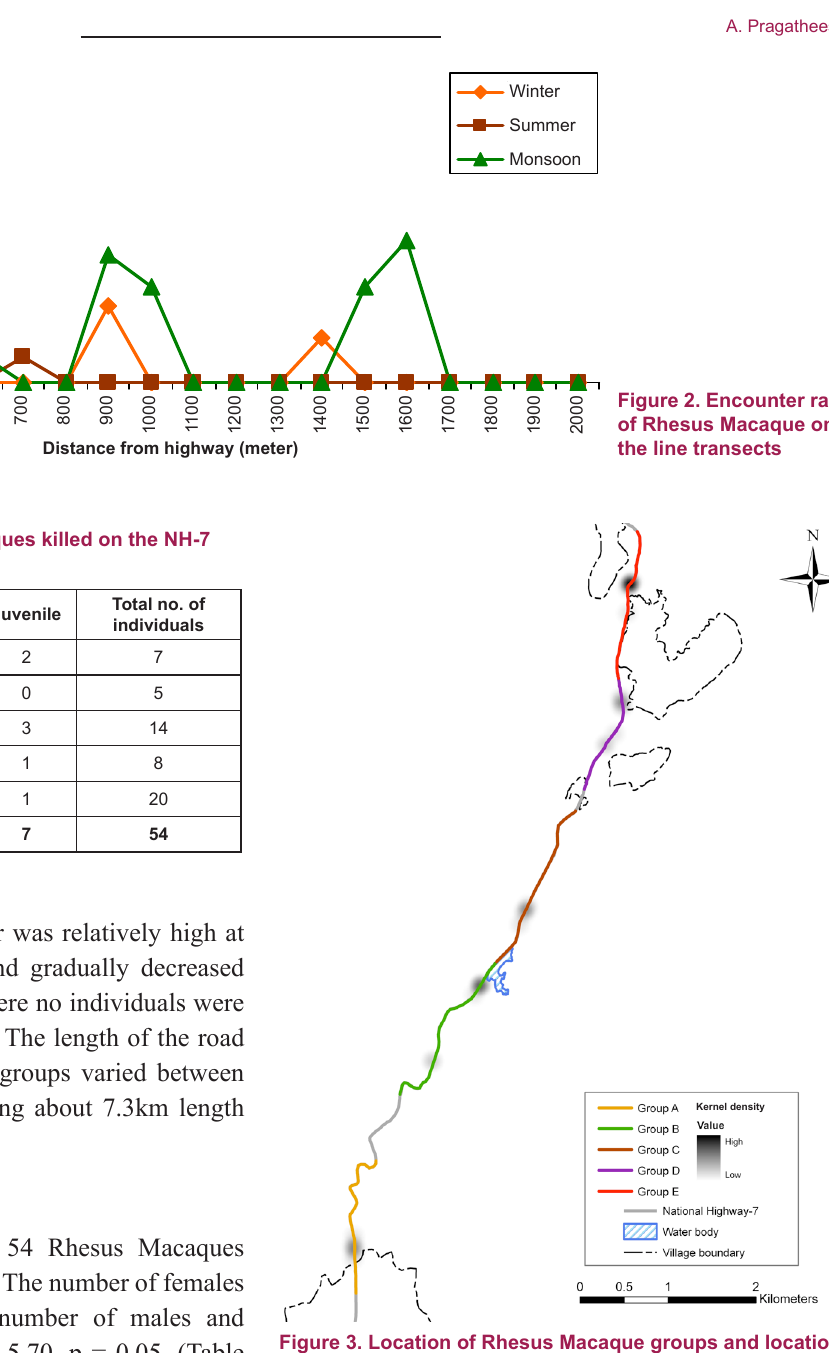
Figure 3. Location of Rhesus Macaque groups and location of road kills